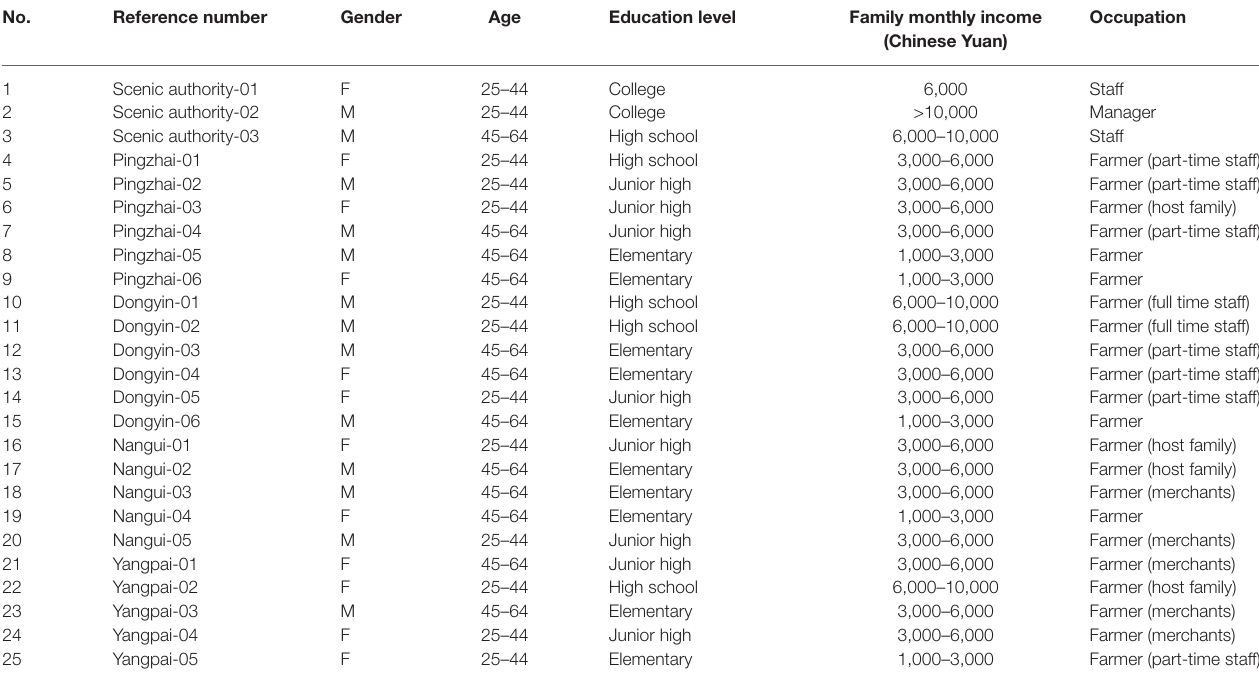
TABLE 3 | Basic information and reference number of